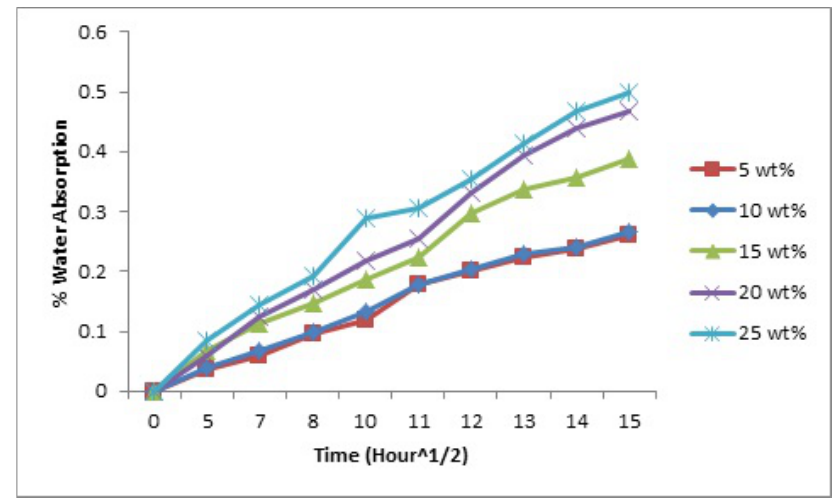
Figure 10: Water absorption versus square root of hours (